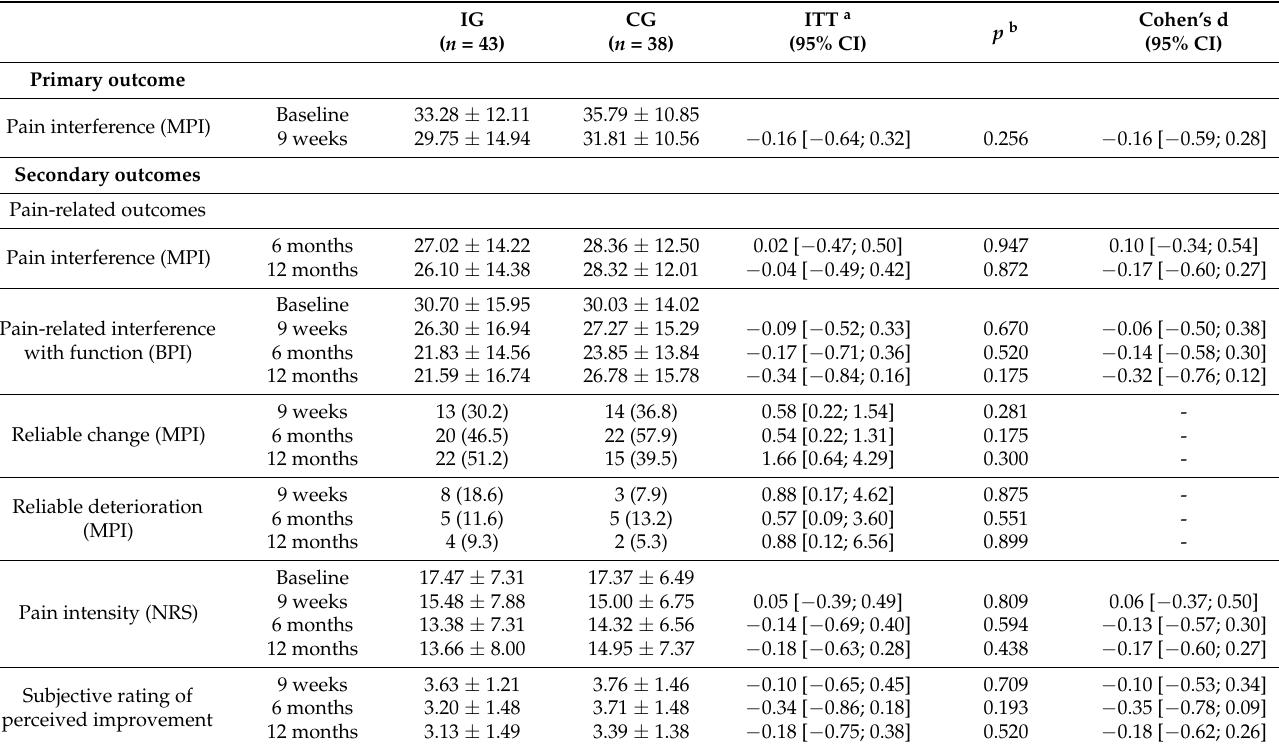
Table 2. ITT Analysis of primary and secondary outcomes at 9-week post-randomization (T1), 6-month (T2) and 12-month (T3)